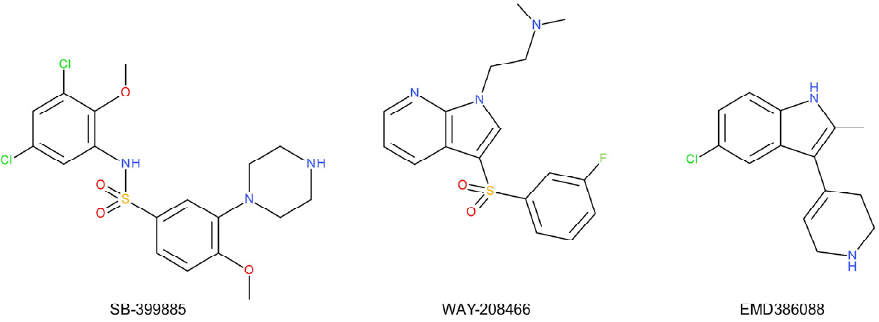
Figure 9. 5-HT 6 receptor ligands: SB-399885, WAY-208466, and